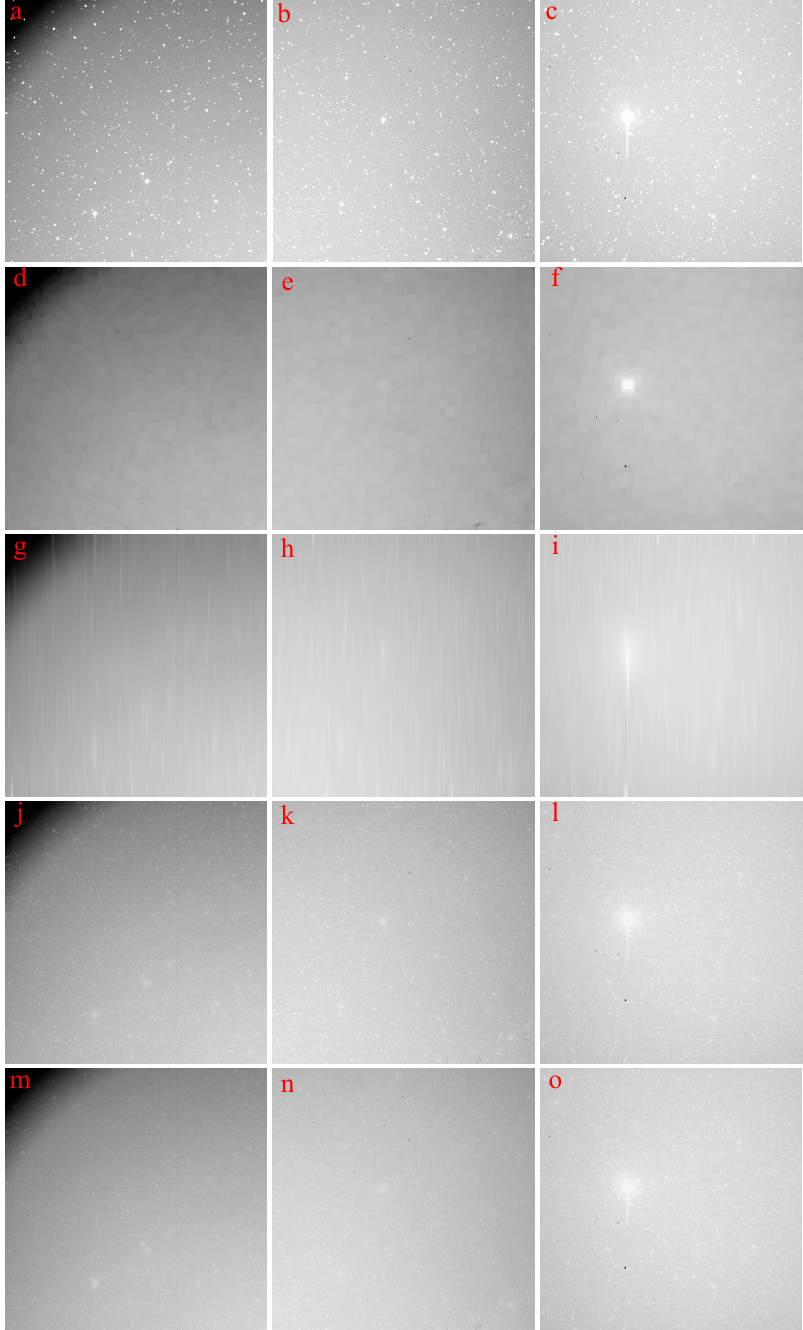
Figure 12. Nonuniform background estimation by different algorithms. ( a – c ) Real original surveillance images. Nonuniform backgrounds estimated by ( d – f ) THT; ( g – i ) MIF; ( j – l ) INTHT; and ( m – o ) IBSGM.